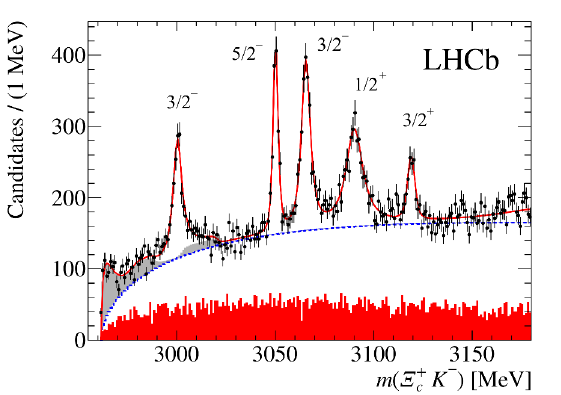
Figure 1. Proposed assignment of spins and parities of excited Ω c states observed by LHCb Collabora- tion